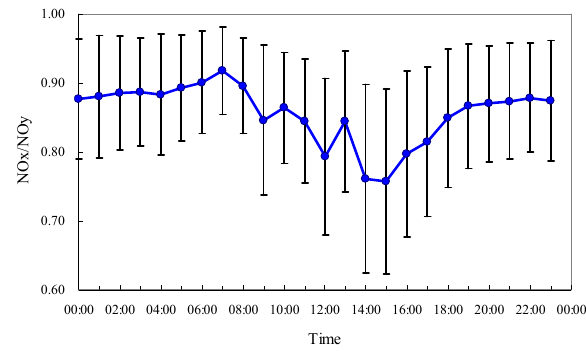
Fig. 9. The average diurnal variation of NO x /NO y ( ± 1 σ for error Fig. 9 The average diurnal variation of NO x /NO y (±1 σ for error bar) bar). (as shown in Table 4), which helps the conversion of sur- face NO to NO 2 . This leads to much lower NO/NO y ( ≤ 0.21)